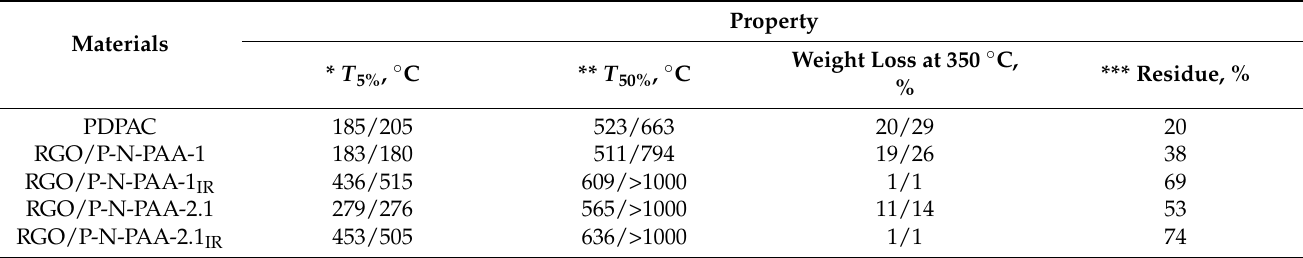
Table 1. Thermal properties of nanocomposites.